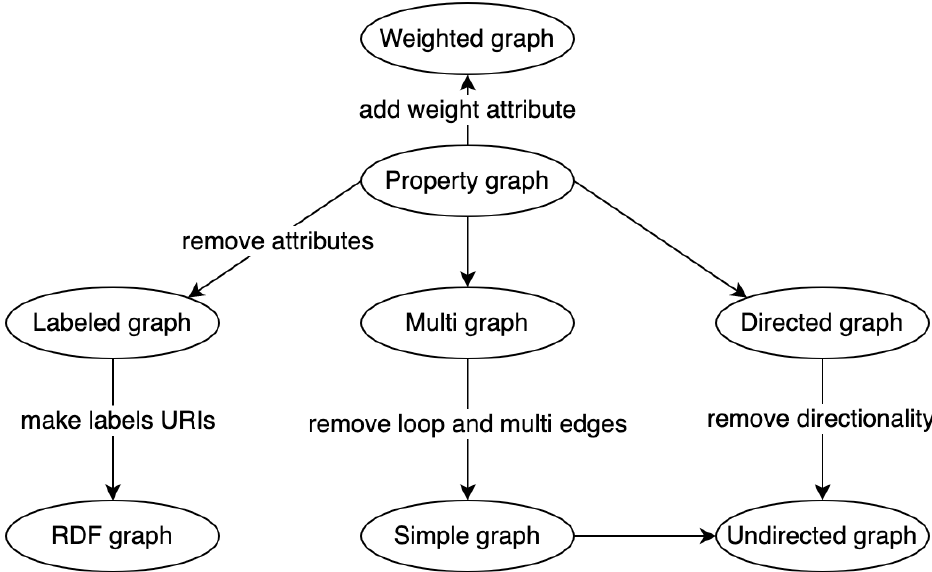
Figure 8. Types of graphs and their relationships.